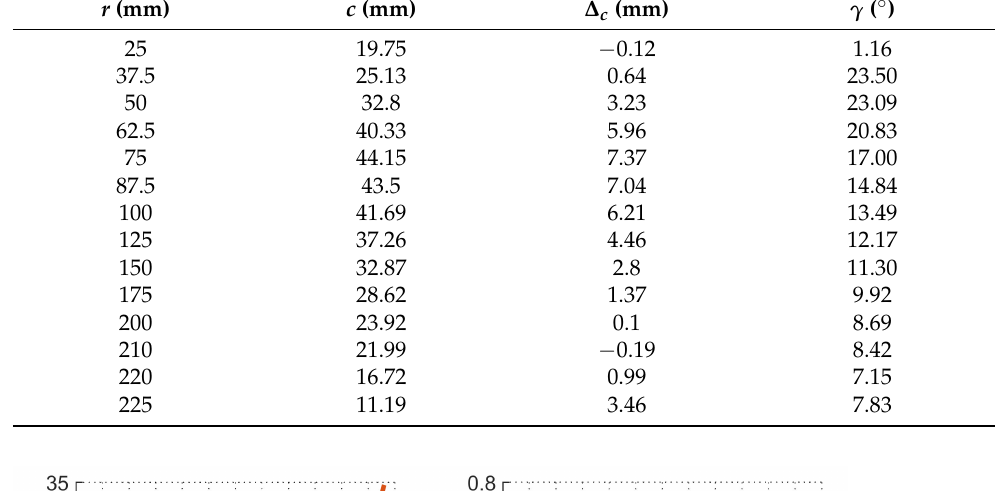
Table 2. Rotor chord, chord center shift, and blade twist distribution along the rotor span.